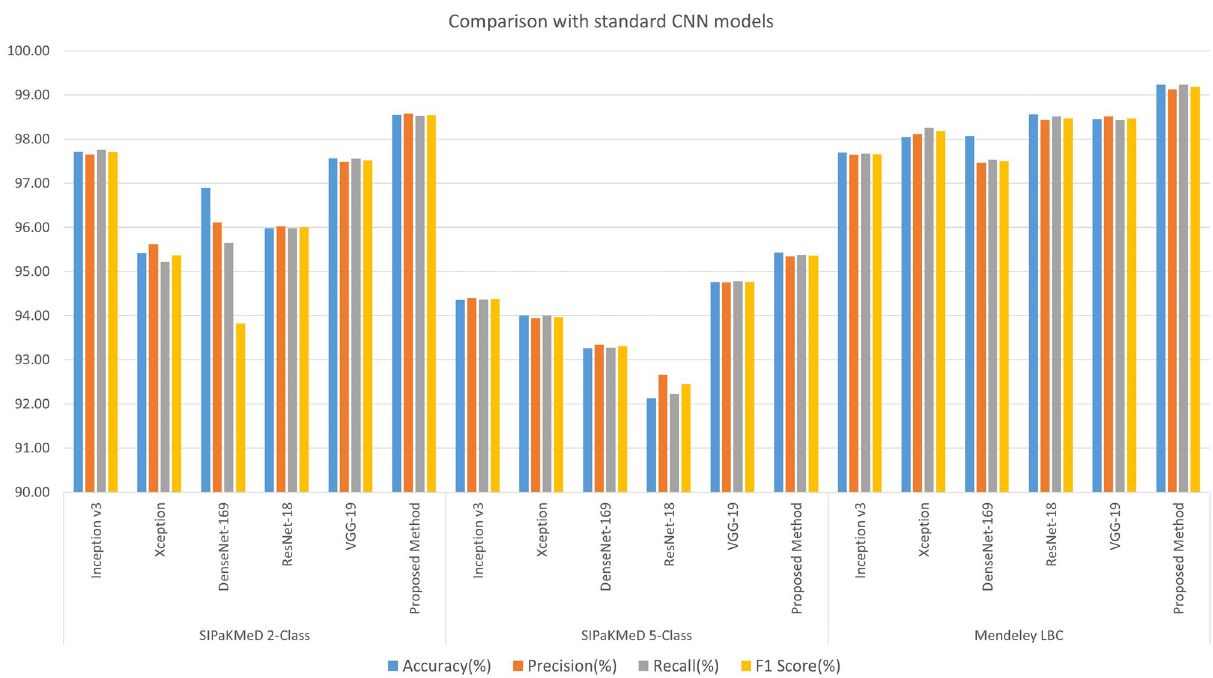
Figure 14. Comparison of the proposed ensemble model with some standard CNN models in literature: Inception v3 4 , Xception 5 , DenseNet-169 6 , ResNet-18 22 , VGG-19 23 (image has been made by R.K. using Google